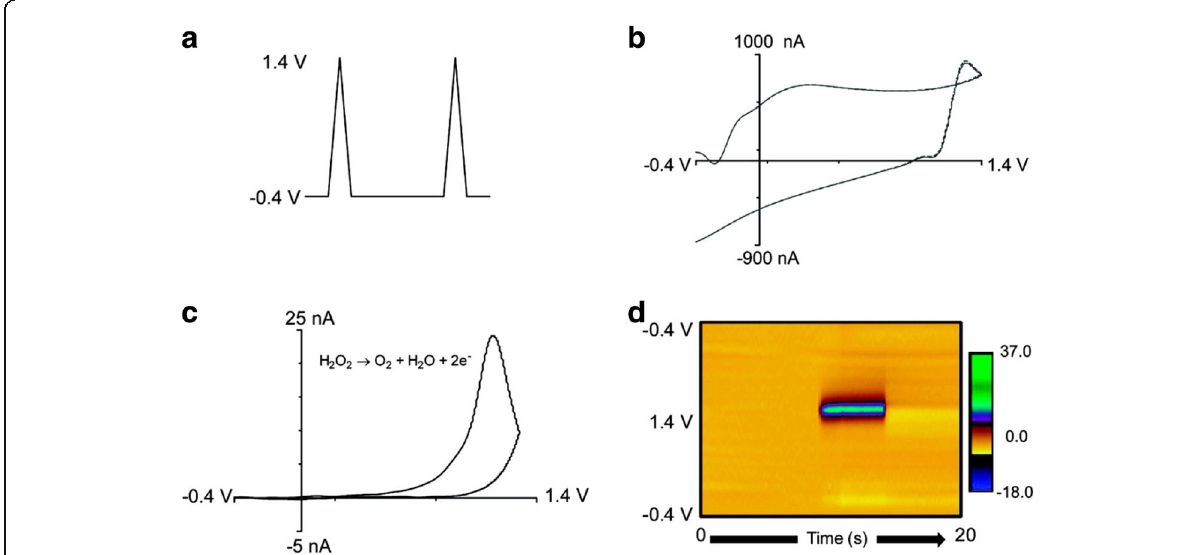
Fig. 7 Fast-scan cyclic voltammetry of H 2 O 2 . a The applied potential was scanned at 400 V s − 1 . b Background current at the carbon surface produced by the rapid scan (solid line). c Background-subtracted cyclic voltammogram of 100 μ M H 2 O 2 at pH 7.4. d Color plot containing 200 background-subtracted cyclic voltammograms recorded over 20 s. (Reprinted with permission from Reference Sanford et al. 2010). © 2010 American Chemical